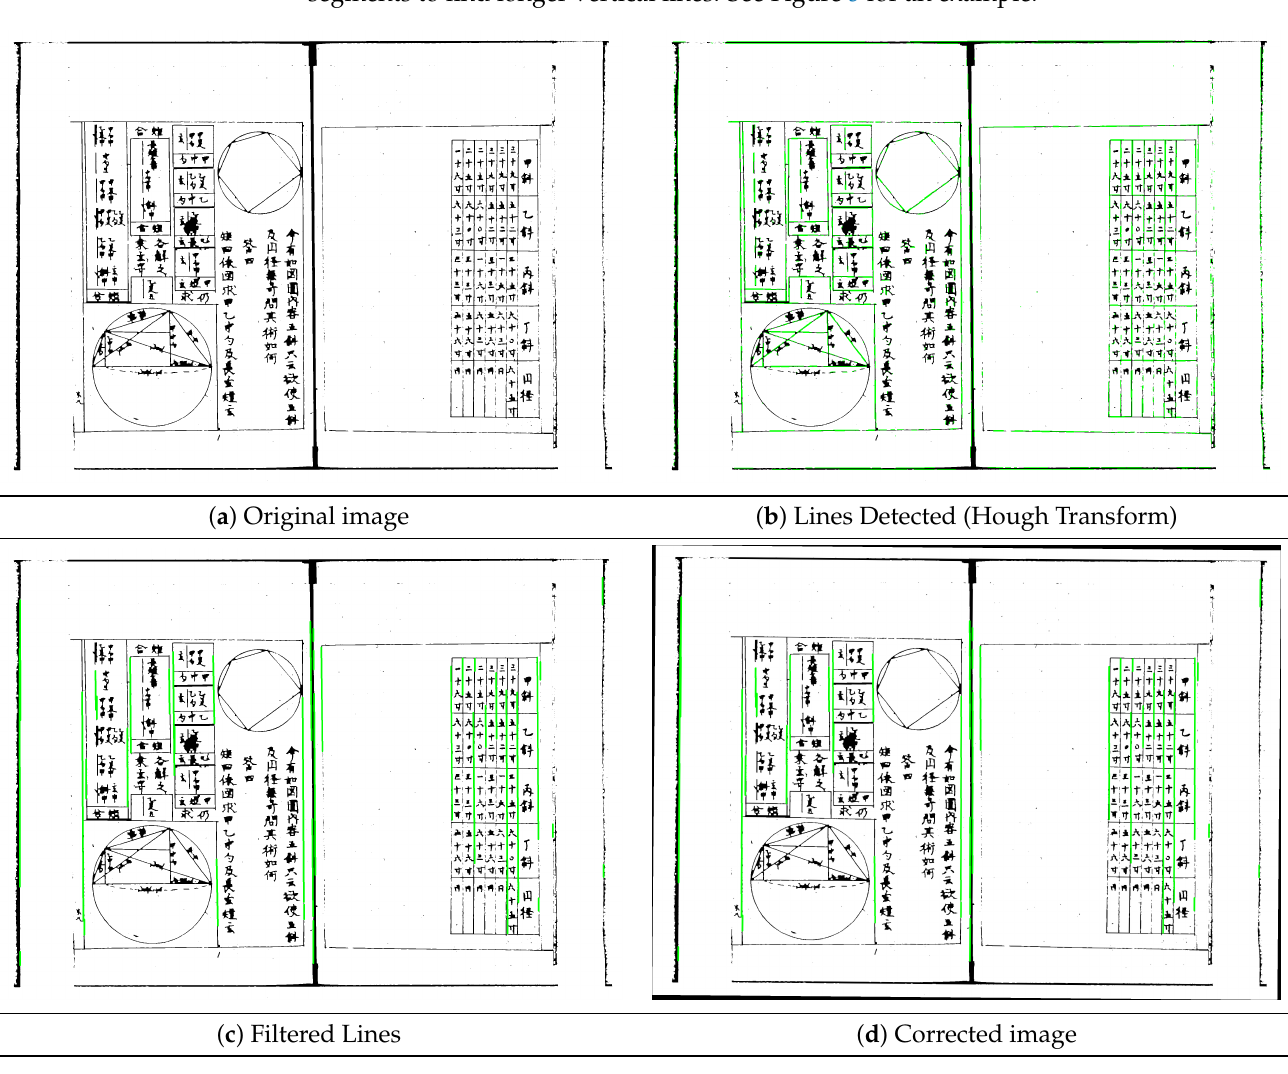
Figure 5. Orientation